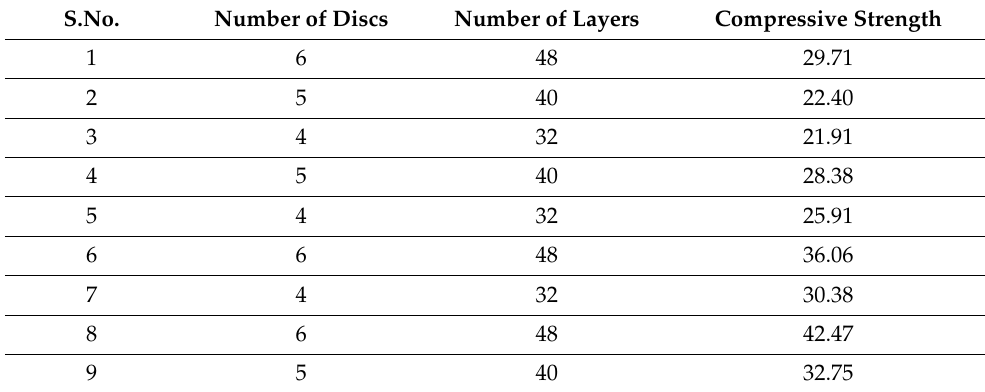
Table 10. Compressive strength Vs. the number of infill layers.